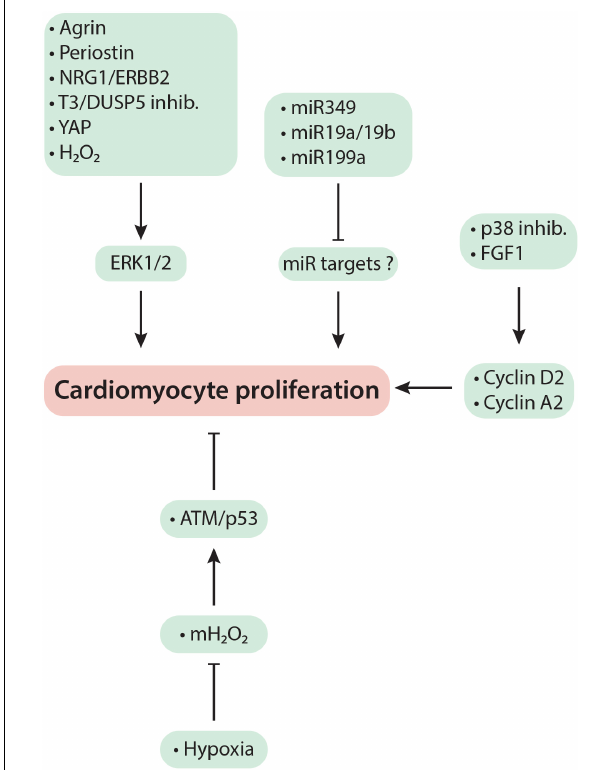
FIGURE 1 | Mechanism-based cardiac regeneration strategies in mammals. See text for a detailed discussion of the mechanisms exploited by each regenerative